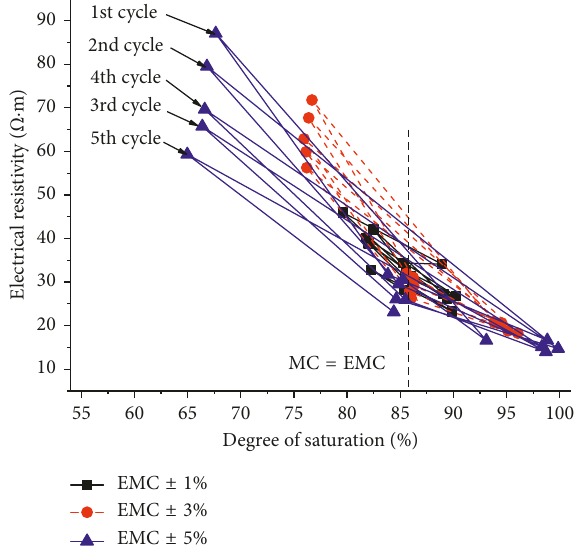
Figure 14: Relationship between degree of saturation and electrical resistivity during wetting-drying cycles.